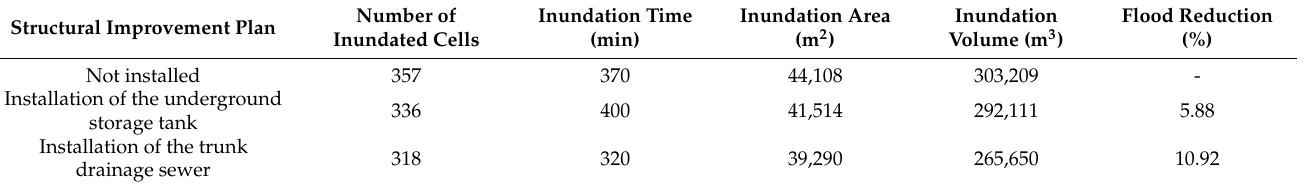
Table 6. Flood analysis in the Dorim watershed according to the reduction facility installation